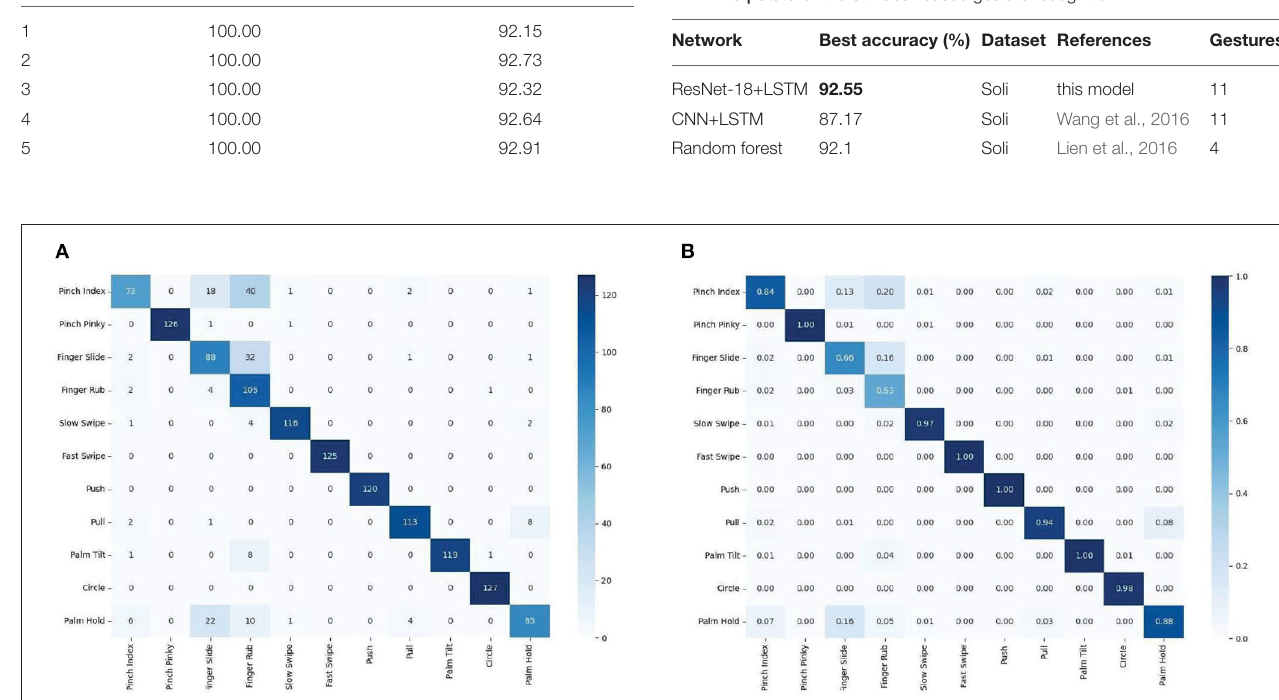
Frontiers in Neurorobotics |